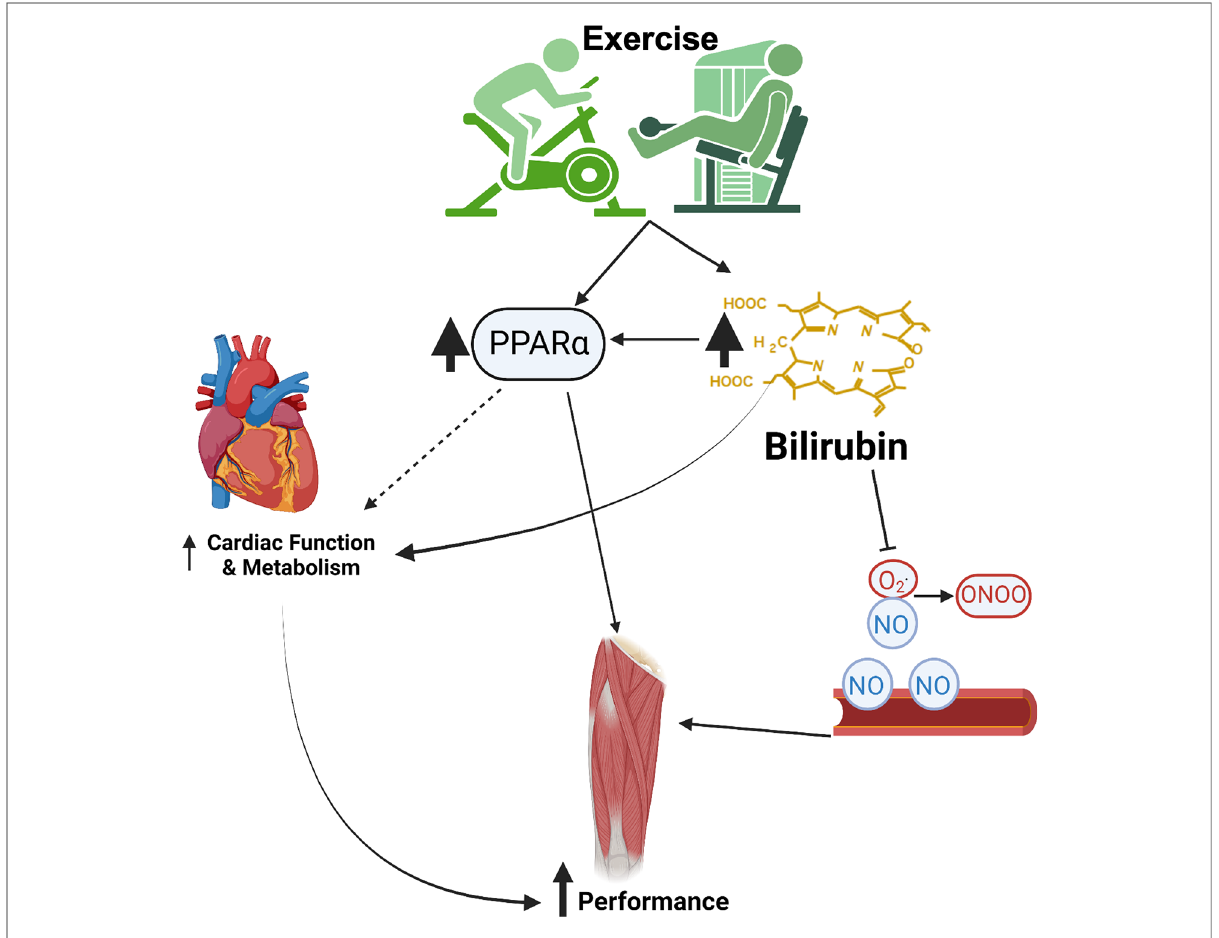
FIGURE 3 Cardiovascular bene fi ts of exercise and bilirubin. This image was made using